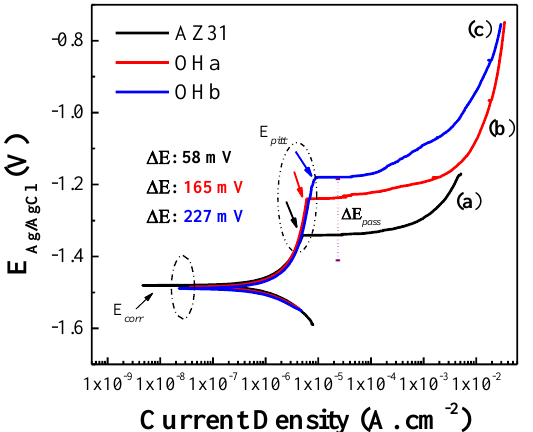
Figure 3. (CP results for the ( a ) bare and ( b , c ) anodized sample, polarizing 0.5 (AZ31OHa) and 1 h (AZ31OHb), respectively, using HBSS.